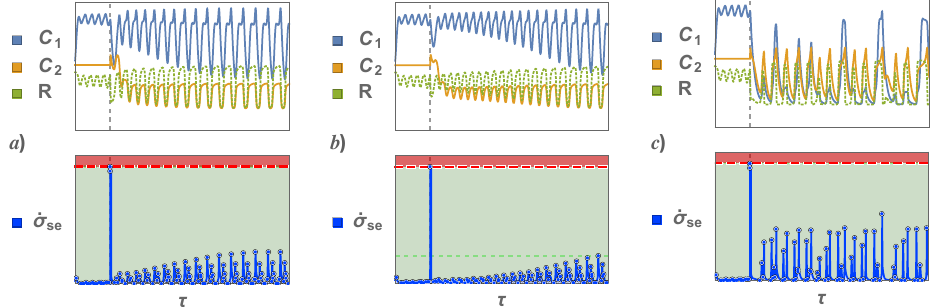
Figure 6. Illustration of the different nature of possible solutions in terms of the populations dynamics (upper panels) and the corresponding social-ecological entropy production (lower panels) of the P-D mode of knowledge-transfer method. ( a ) Sustainable: The post-intervention dynamics has low entropy production rate after the intervention by the second community. The dynamics tends to an asymptotic behavior, making this scenario a very resilient one. ( b ) Sustainable: The post- intervention dynamics is still sustainable but entropy production rate tends to increase with time after the intervention by the second community, indicating a fragile post-intervention behavior. ( c ) Sustainable: The dynamics is sustainable but shows chaotic oscillations after the intervention. This reduces the capability of predicting future events. See the main text for a detailed discussion of the results. The figure is own